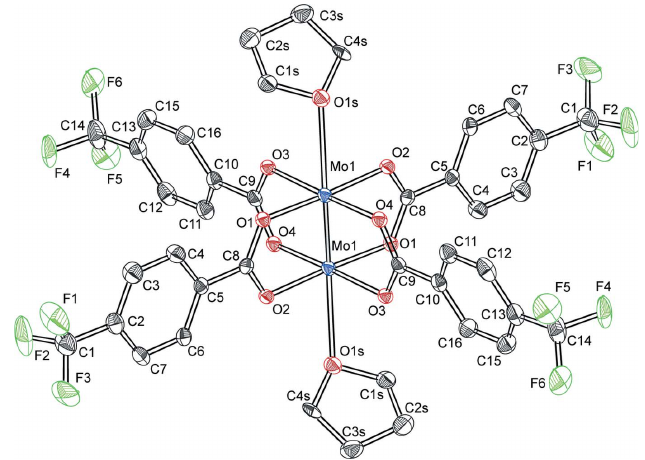
Figure 1 Ellipsoid plot of the dimolybdenum complex. The CF 3 groups are rotationally disordered, therefore the highest occupancy positions are shown for each atom. Hydrogen atoms and unbound solvent are omitted for